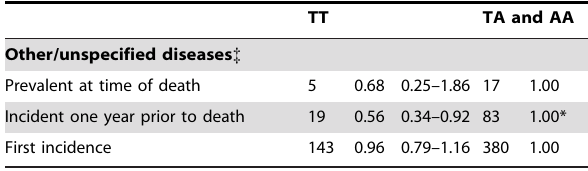
Table 4. FTO rs9939609 (genotype TT vs. TA and AA) and cause-specific mortality and morbidity in 1,628 Danish